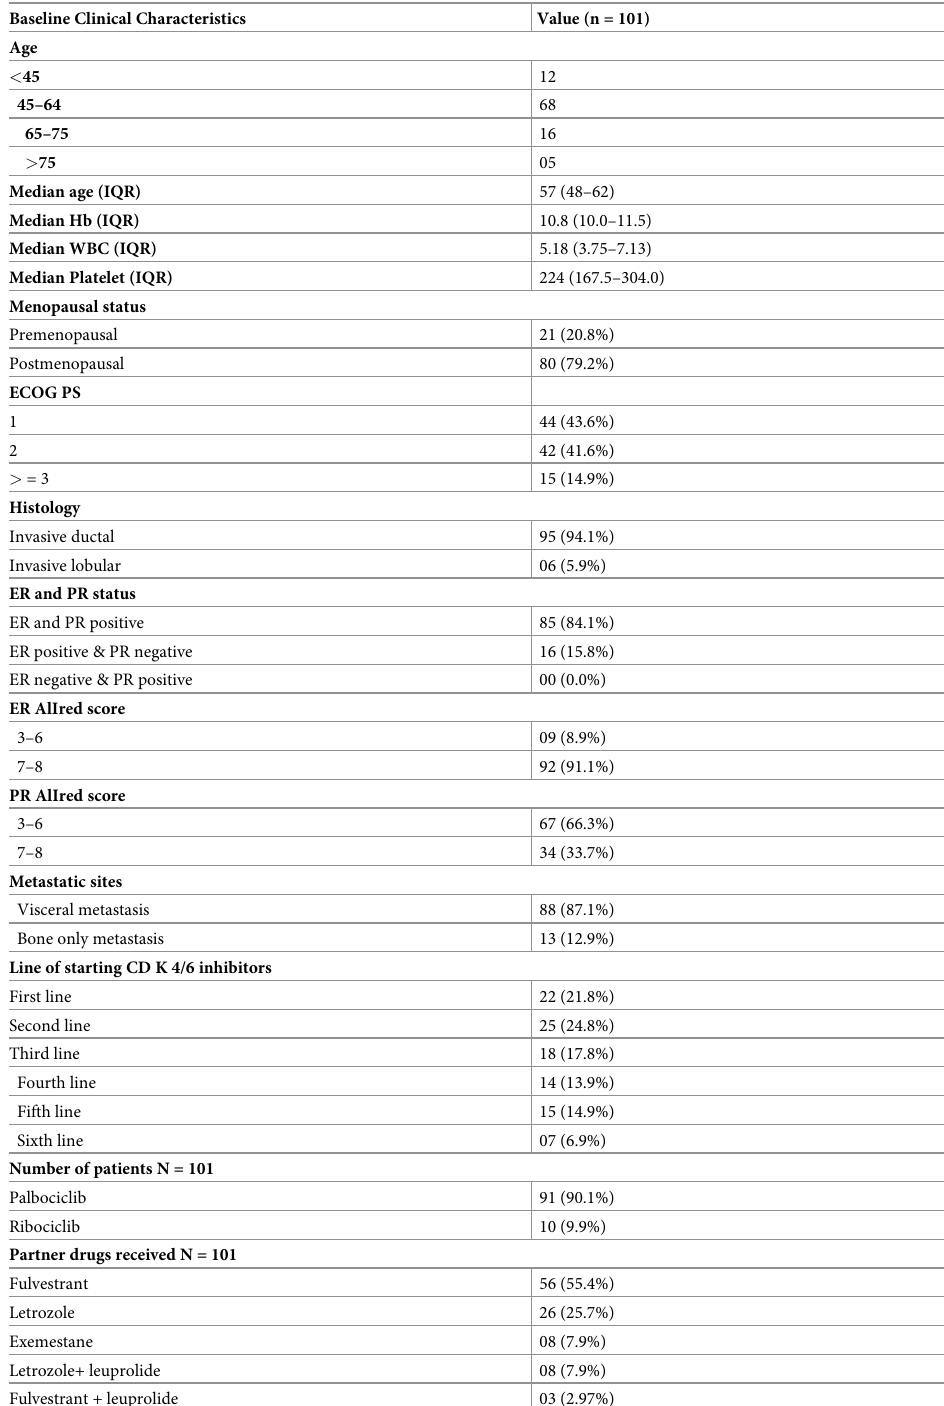
Table 1. Patient characteristics. Baseline Clinical